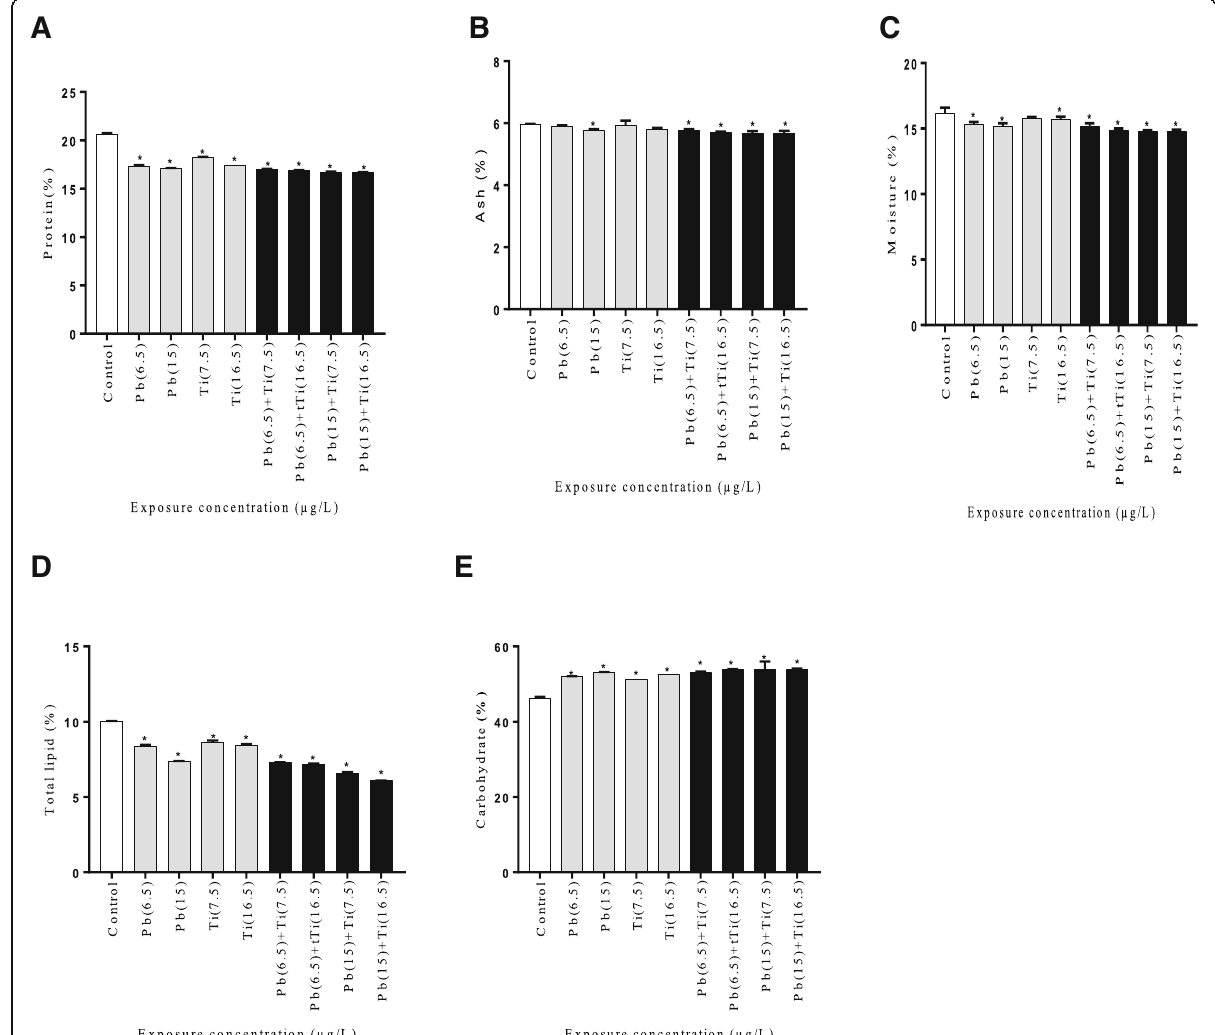
Fig. 1 Proximate composition of Clarias gariepinus fed contaminated copepods after 28 days. a Protein content, F (8, 27) = 2580, P <0.0001. b Ash content, F (8, 18) = 8454, P <0.0001. c Moisture content, F (8, 18), P <0.0001. d Total lipid content, F (8, 18) = 1144, P <0.0001. e Carbohydrate content, F (8, 18), P <0.0001. Threshold replicate were included ( n =3). Errors bars indicate Standard deviation (SD). Ti ie nTiO 2